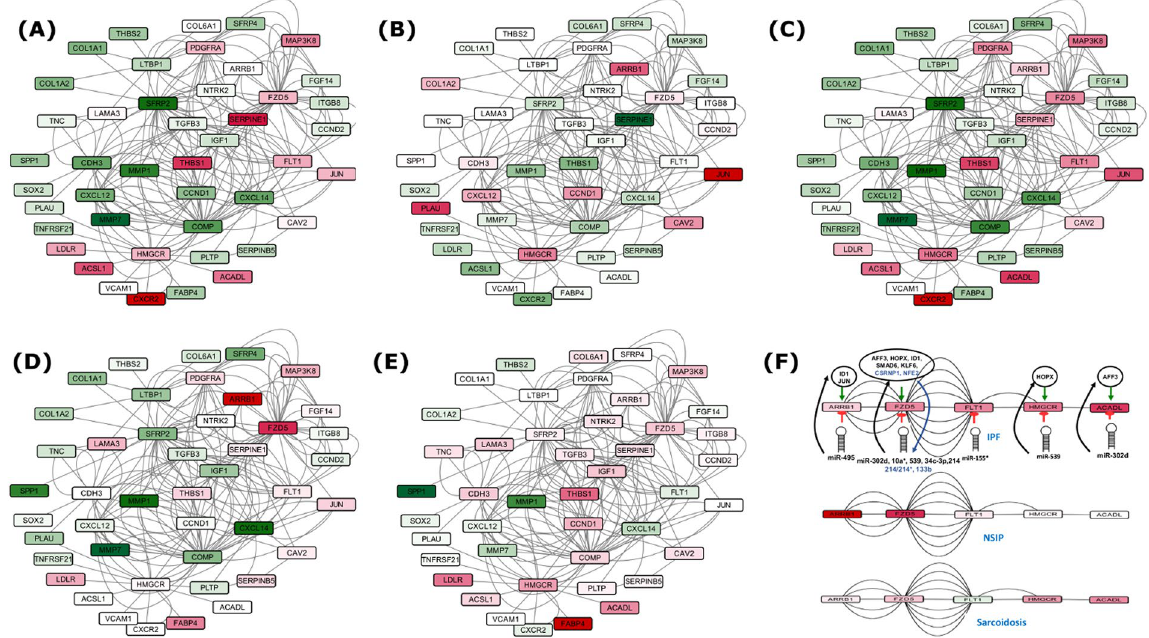
Figure 2. Variation in differential expression of most confident Set A genes along with their first neighbors during IPF progression. ( A ) Normal to Early IPF shifts in differential expression, ( B ) Early to advanced IPF shifts in differential expression, ( C ) Normal to Advanced IPF shift in differential expression, ( D ) differentially expressing genes in NSIP and in ( E ) Sarcoidosis. Green color depicts the degree of overexpression whereas red shows degree of underexpression, ( F ) Critical chain of five serially connected genes (ACADL-HMGCR-FLT1- FZD5-ARRB1) which appeared downregulated in IPF specifically. This chain is broken in Sarcoidosis due to upregulation of FLT1 while in case of NSIP, the chain is not completely formed. Eight TFs and nine miRNAs appeared crucial in regulating IPF through these check